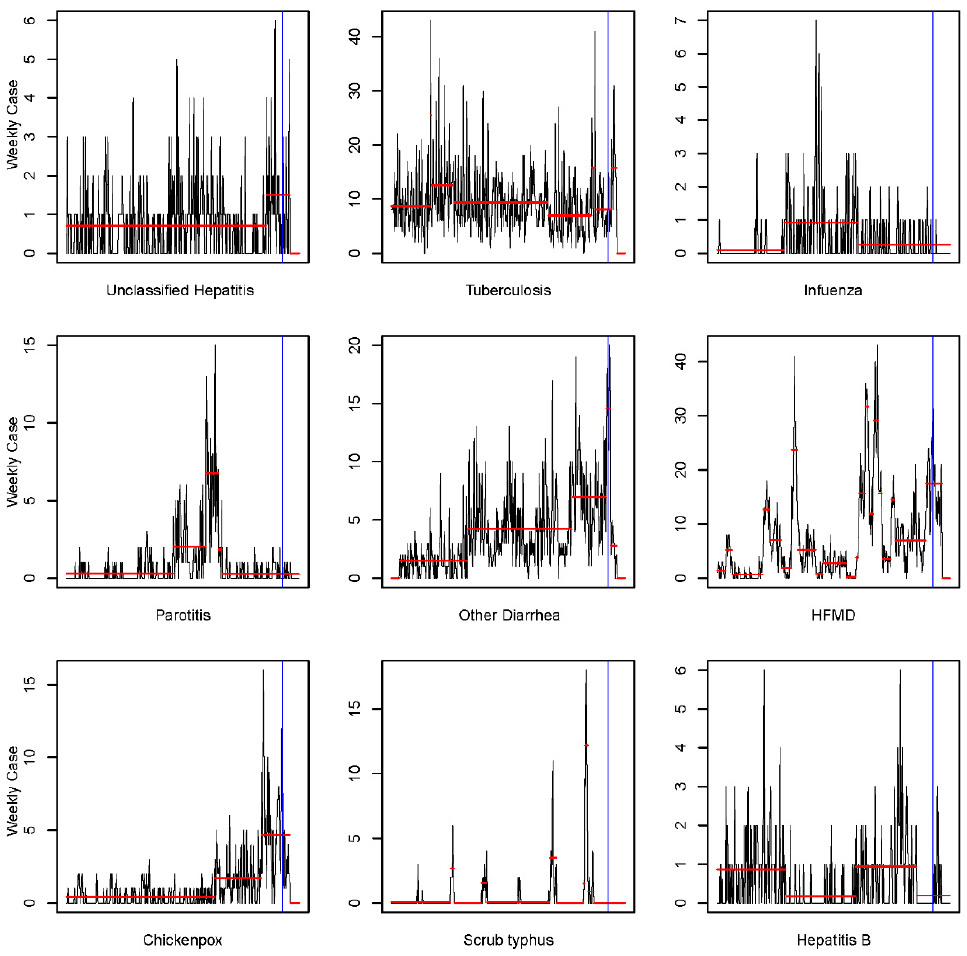
Figure 3. Change-points of notifiable infectious diseases in Funing from January 2010 to September 2016. Results show the time series (1st week, 2010–40th week, 2016) of weekly cases on nine notable infectious diseases. Blue line represents the onset of tornado.